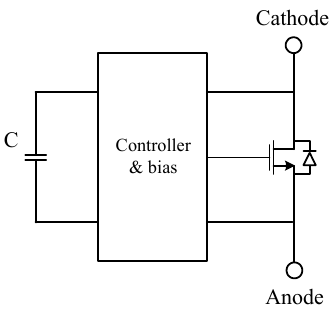
Figure 4. The concept of the cool bypass switch [19].